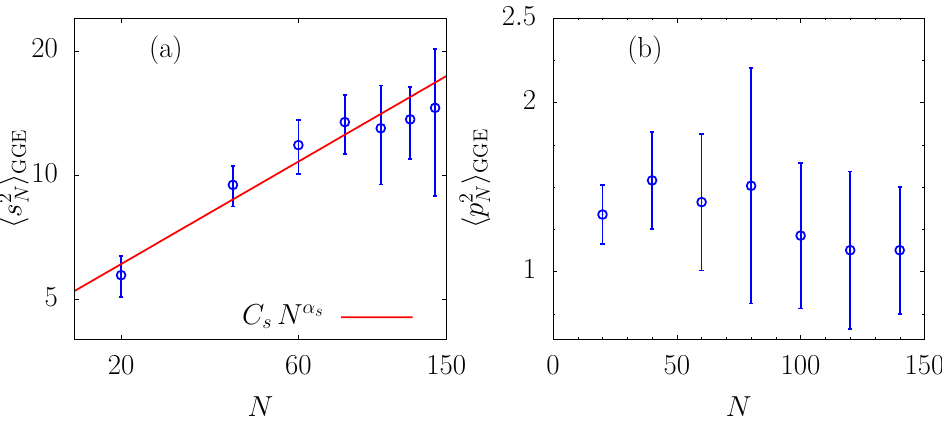
Figure 7: Finite size dependence in phase II, away from the special curve = ( JJ ) 1 / 2 , for parameters T T 0 0 power law fit with parameters C been averaged over up to 50 different realisations of the harmonic constants and the error bars represent the